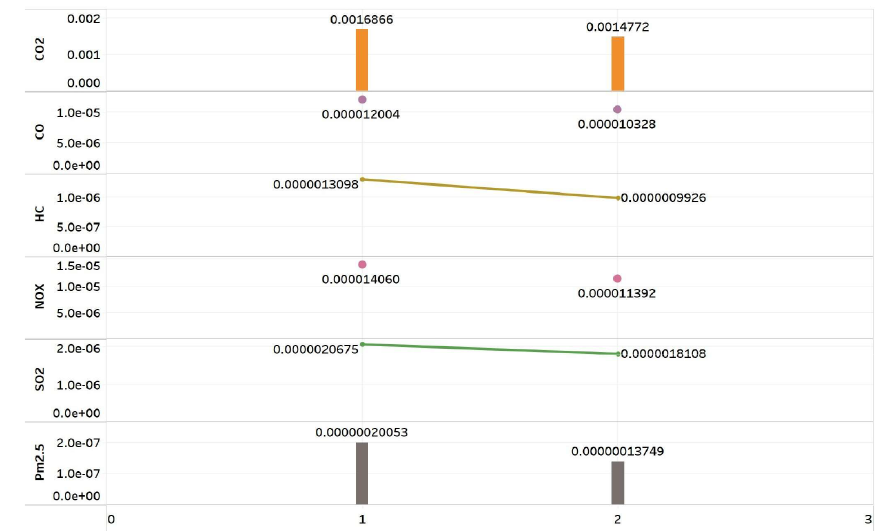
Figure 13. Average unit turnover emissions of each airline before and after CNG2020.